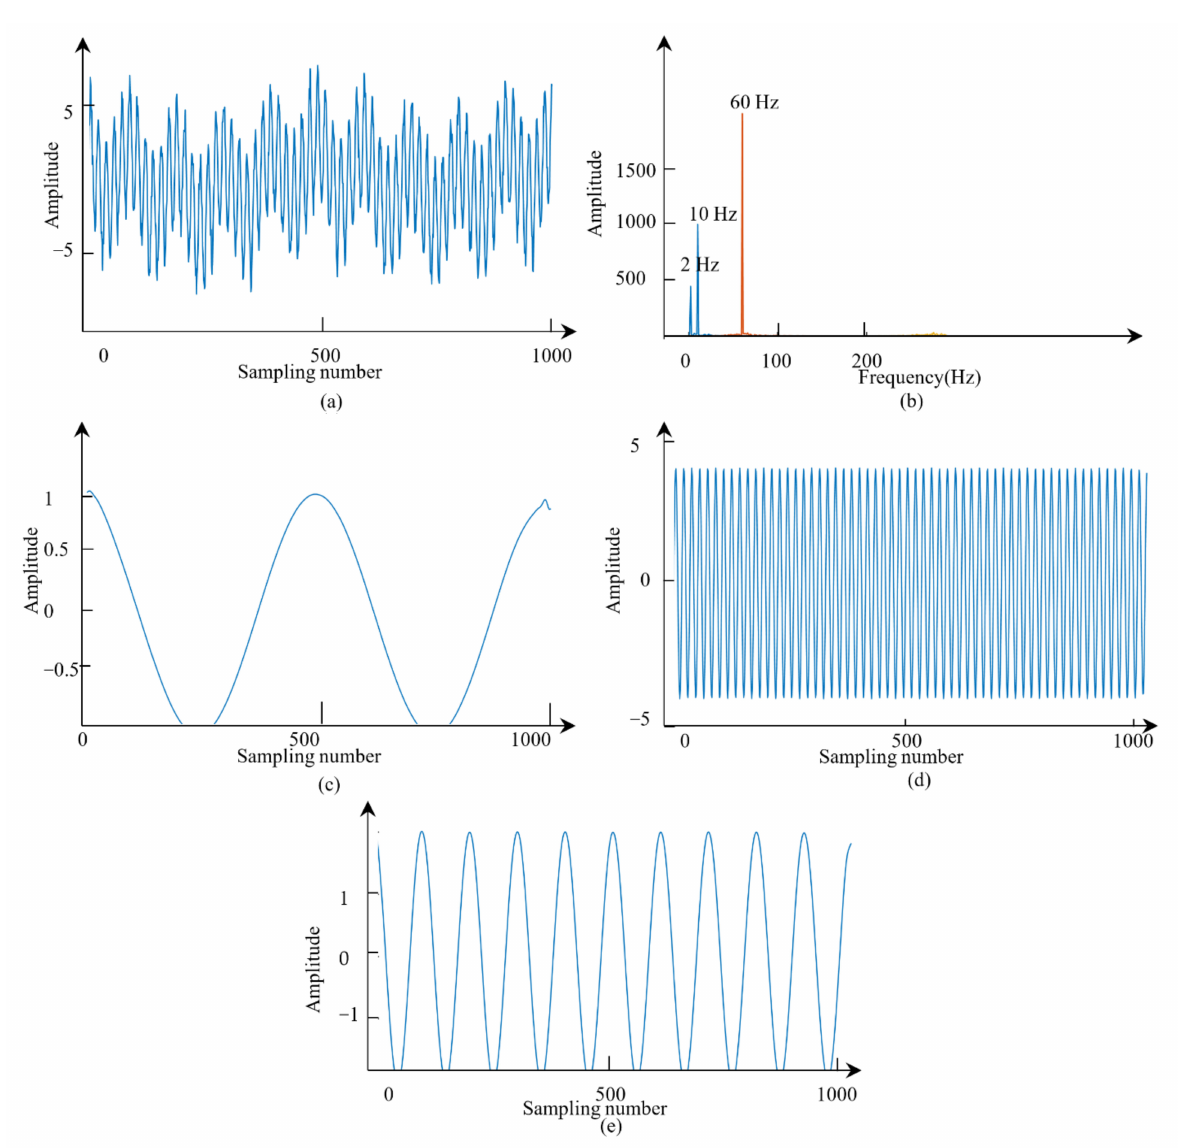
Figure 12b. It is very clear that the three modes had center frequencies of 2 Hz, 10 Hz, and 60 Hz, respectively, and the decomposed signals were very close to the original sub-signals.